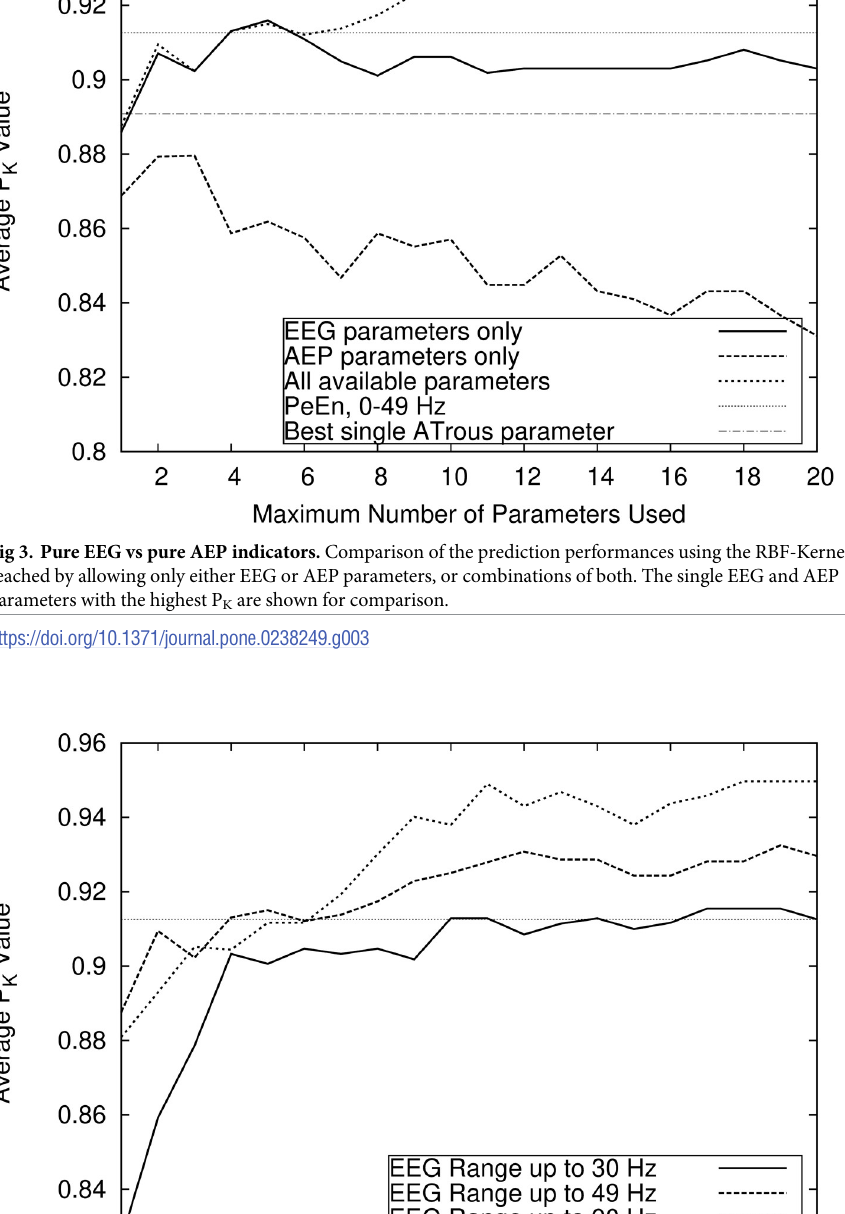
PLOS ONE | https://doi.org/10.1371/journal.pone.0238249 August 26,